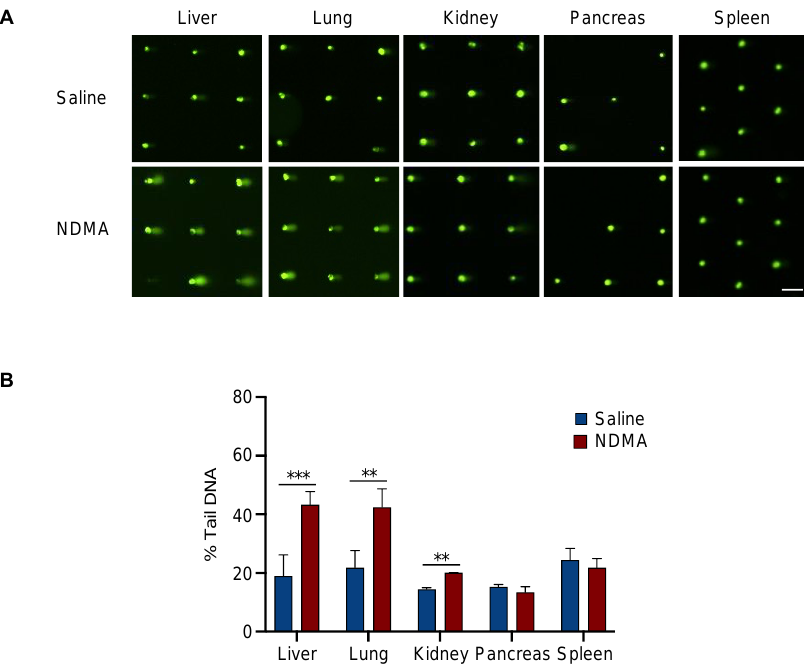
Figure 4. NDMA induces DNA damage in metabolically active mouse tissues 24 h after exposure. Mice were either sham treated or exposed to NDMA, and liver, lungs, kidneys, pancreas and spleen were collected 24 h after injection and analyzed with the alkaline CometChip. ( A ) Representative fluorescent comet images from various mouse tissues treated with NDMA. ( B ) Quantification of percent tail DNA showing the mean of three mice ± SD. Unpaired Student’s t -test, ** p < 0.01, *** p < 0.001. Scale bar = 100 μ m.